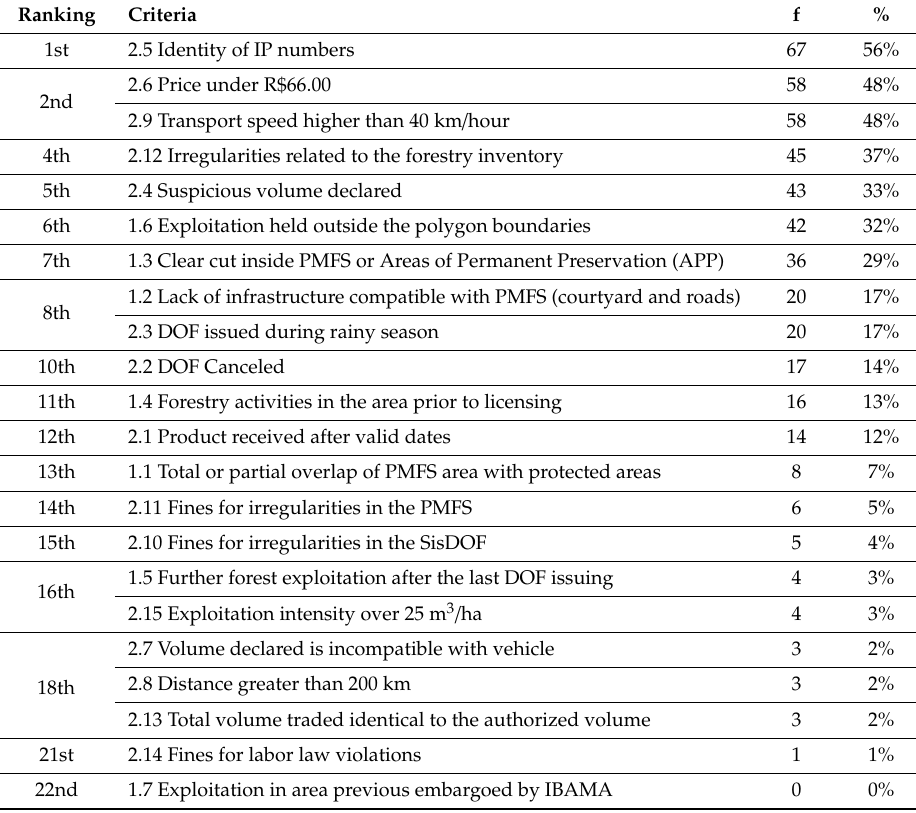
Table 4. Frequency ranking by